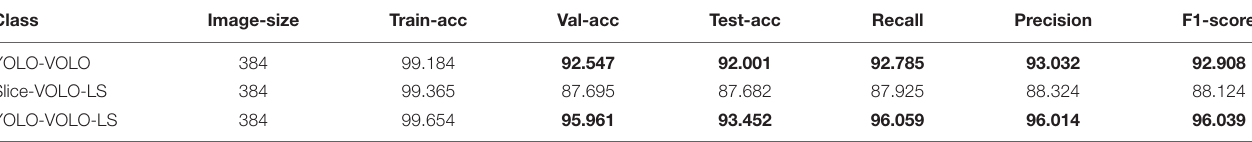
TABLE 5 | Classification model results of SP stage of lettuce based on YOLO-VOLO.